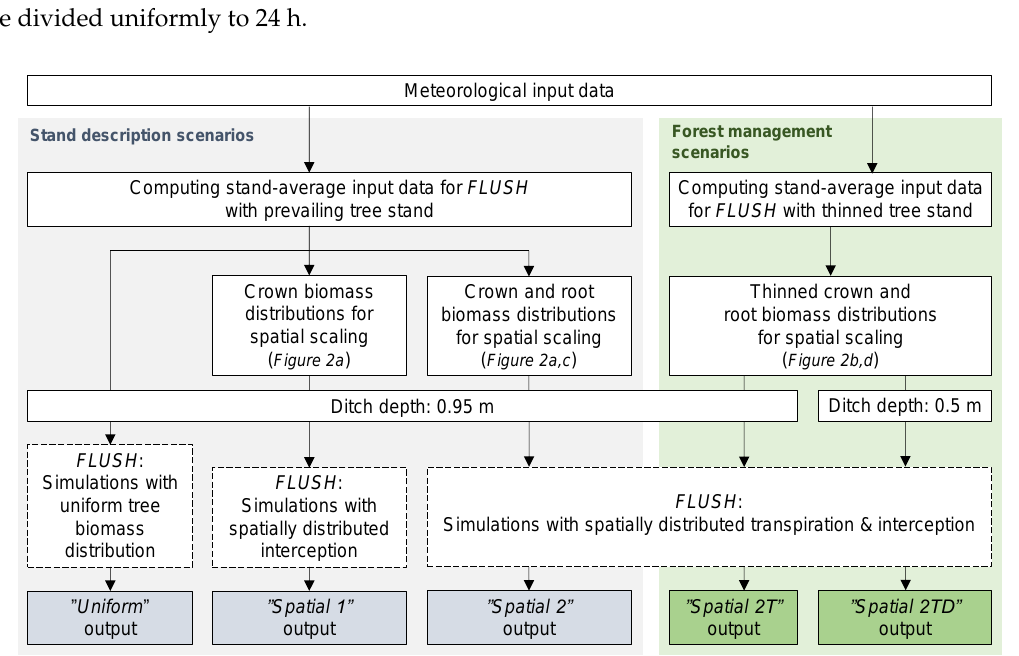
Figure 3. Conceptualization of the modeling processes for stand description ( Uniform , Spatial 1 , and Spatial 2 ) and forest management scenarios ( Spatial 2T and Spatial 2TD ). For FLUSH model, see Section